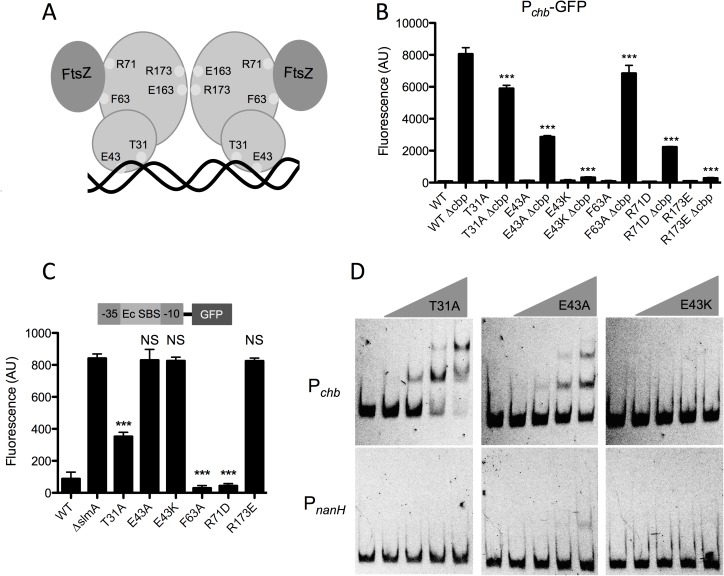
DNA binding, but not nucleoid occlusion activity, is required for SlmA-dependent transcriptional activation of Pchb.(A) Schematic of SlmA depicting residues mutated in this study. T31 and E43 are predicted to interact with DNA, F63 and R71 mediate FtsZ interactions, and R173 is required for dimerization. (B) GFP fluorescence was measured in strains containing a Pchb-gfp reporter and the indicated site-directed mutations in the native copy of slmA. Statistical comparisons are made to the “WT Δcbp” sample. (C) GFP fluorescence was assessed in strains harboring an SBS-gfp reporter that is a readout for DNA binding and contain the indicated site-directed mutations in the native copy of slmA. Statistical comparisons are made to the “ΔslmA” sample. (D) EMSAs performed with the WT Pchb probe or the negative control PnanH probe incubated with (from left to right): 0 nM, 240 nM, 480 nM, 960 nM, or 1920 nM of the indicated SlmA mutant protein. Data in B and C are shown as the mean ± SD and are from at least three independent biological replicates. Data from D is representative of at least two independent experiments. *** = p<0.001, NS = not significant.